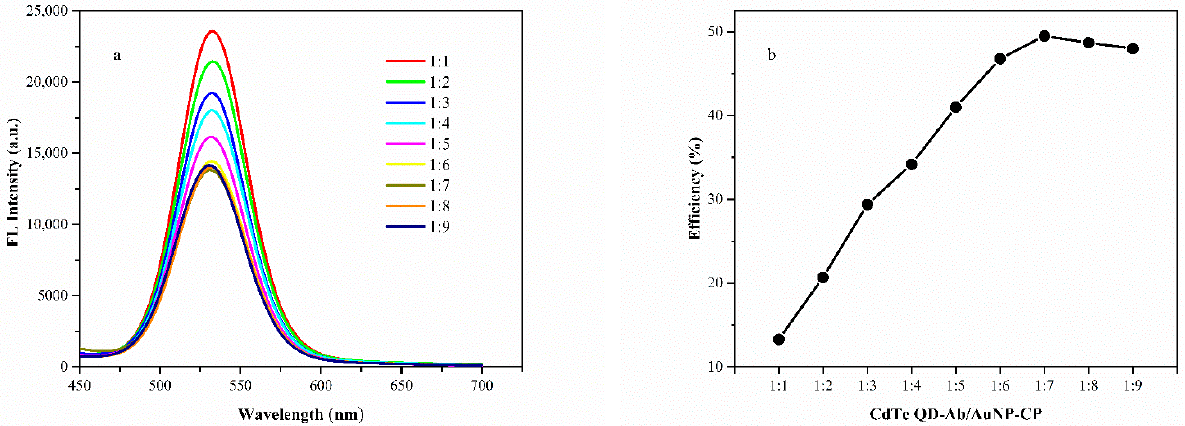
Figure 6. Quenched fluorescence ( a ) and FRET efficiency ( b ) of the developed biosensor at different proportions of CdTe QD-Ab and proportions of CdTe QD-Ab and AuNP-CP.